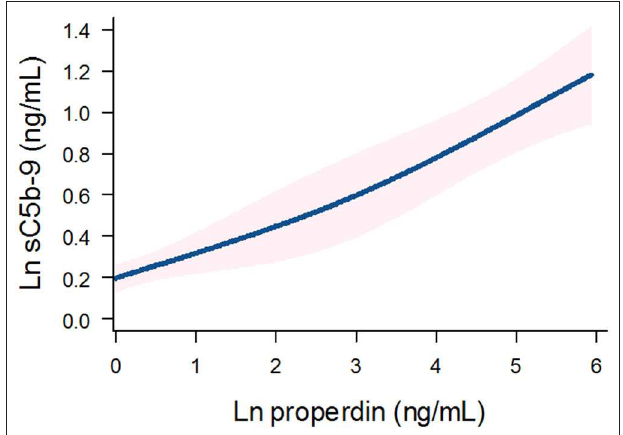
FIGURE 2 | Association between urinary properdin and urinary sC5b-9 excretion in the RTR. A restricted cubic spline is generated based on linear regression analyses. Knots are placed on 10th, 50th, and 90th percentile of ln properdin. Blue line represents the coefficient, and pink band represents the 95% confidence